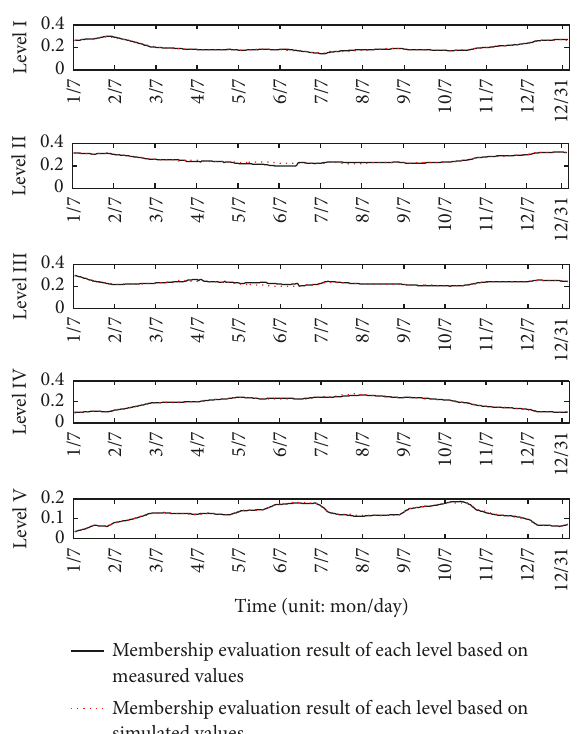
Figure 8: Membership evaluation result of each level based on the measured values and simulated values of